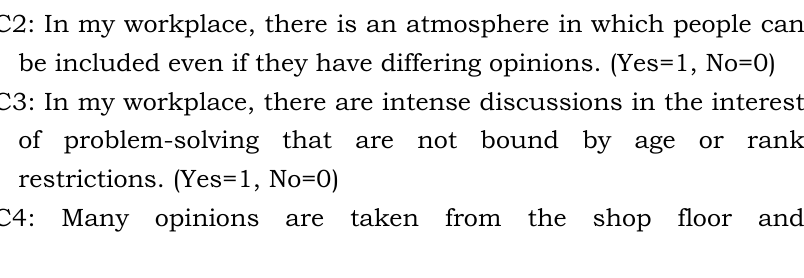
Table 2. Mean, S.D., and correlations of the items of